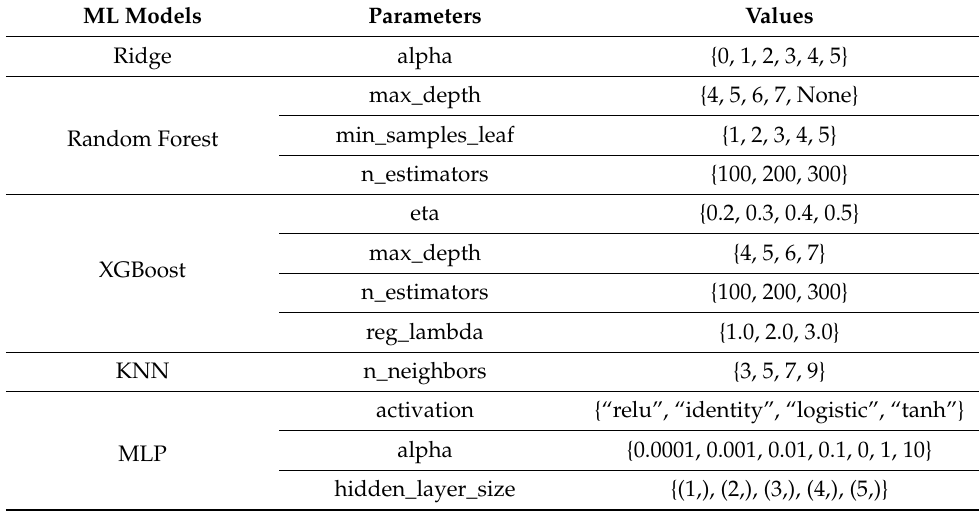
Table 1. Hyper-parameters and their values in our